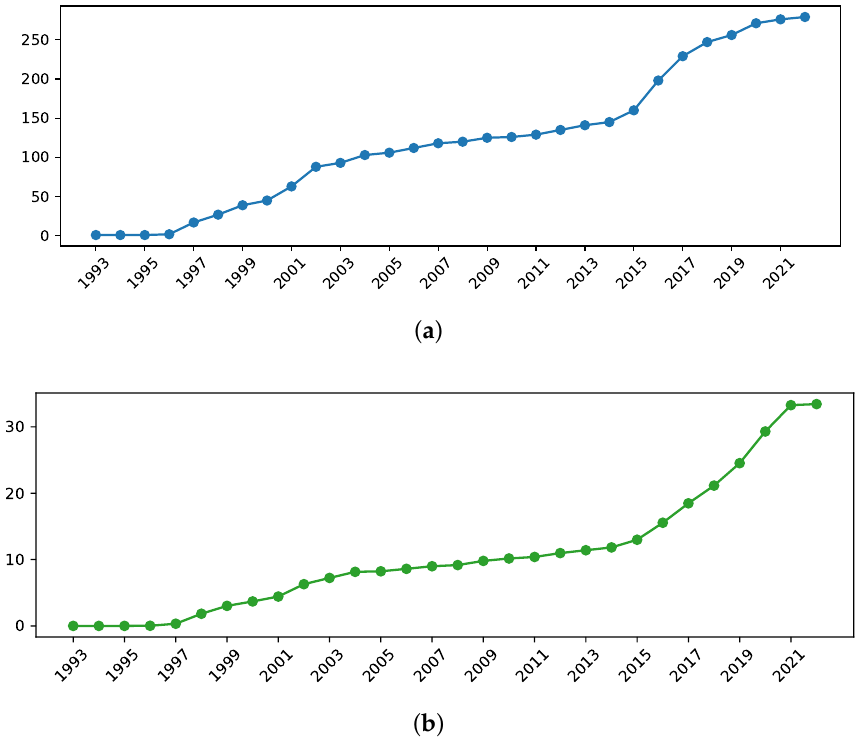
Figure 5. Evolution of network statistics of the technology-convergence network. It can be observed that both the number of nodes and the average degree moderately increase in most years, which matches with the characteristic of self-similar growth, in that the network size moderately grows over time. ( a ) Number of nodes in the largest connected component of hist degree of G